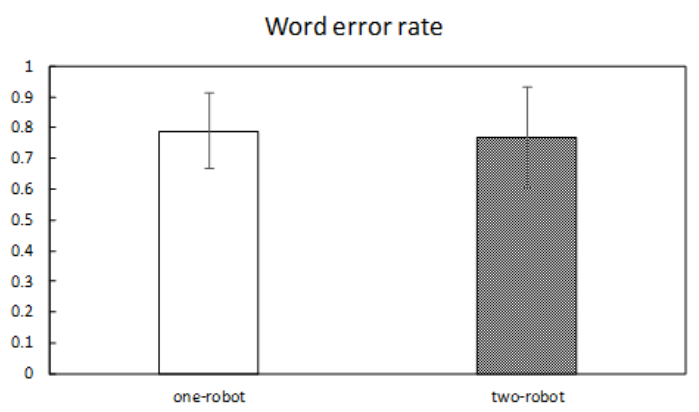
Figure 7. The averages of the word error rate (WER) in each scenario.